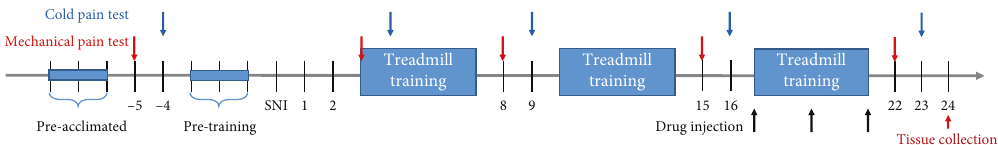
Figure 1: Schematic timeline for behavior detection and treadmill exercise. The red arrow represents the mechanical pain test. The blue arrow represents the cold pain test. The black arrow represents the drug injection time. The numbers represent the days of spared nerve injury surgery. Preacclimated was performed 30 min/day in pain test environment. Pretraining was performed 10 m/min/10min/day. Treadmill training was performed 10m/min/30 min/day/5 days/3